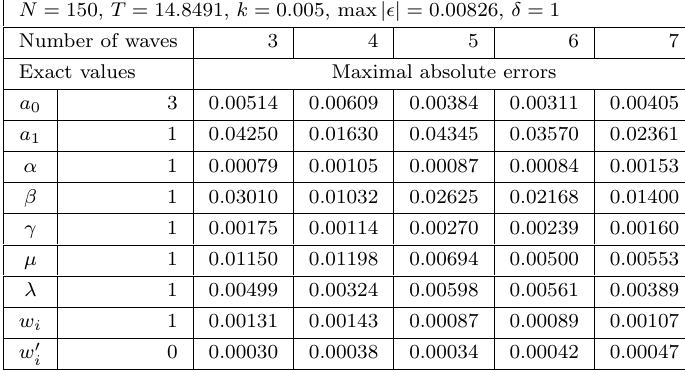
Table 2. Maximal absolute errors (wave profile, macro- and microdeformation).